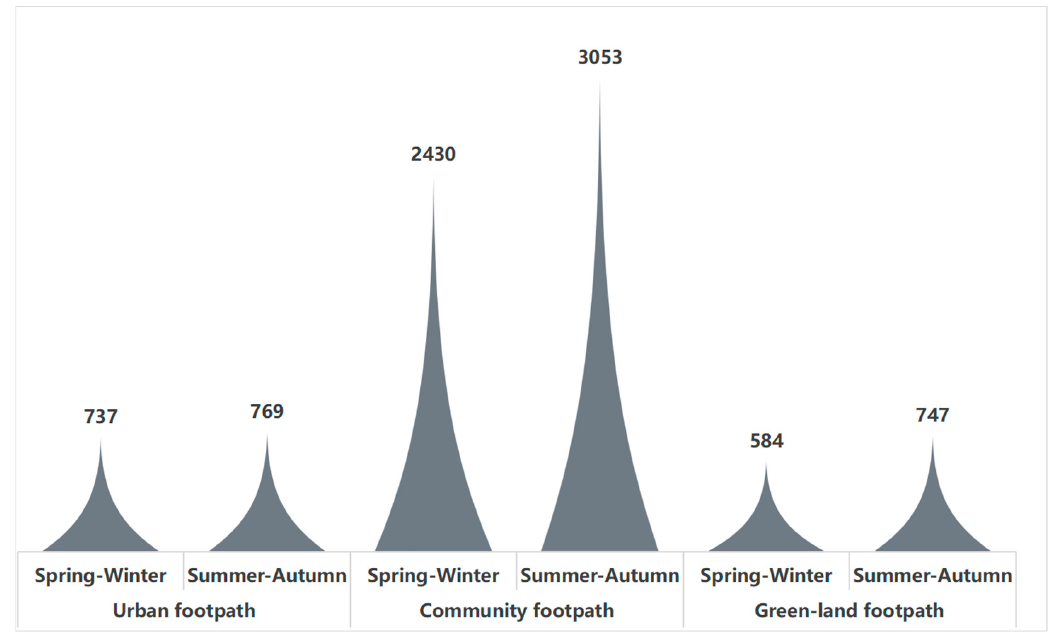
Figure 9. Statistics of the number of jogging trajectories in different seasons (different types of foot- paths).